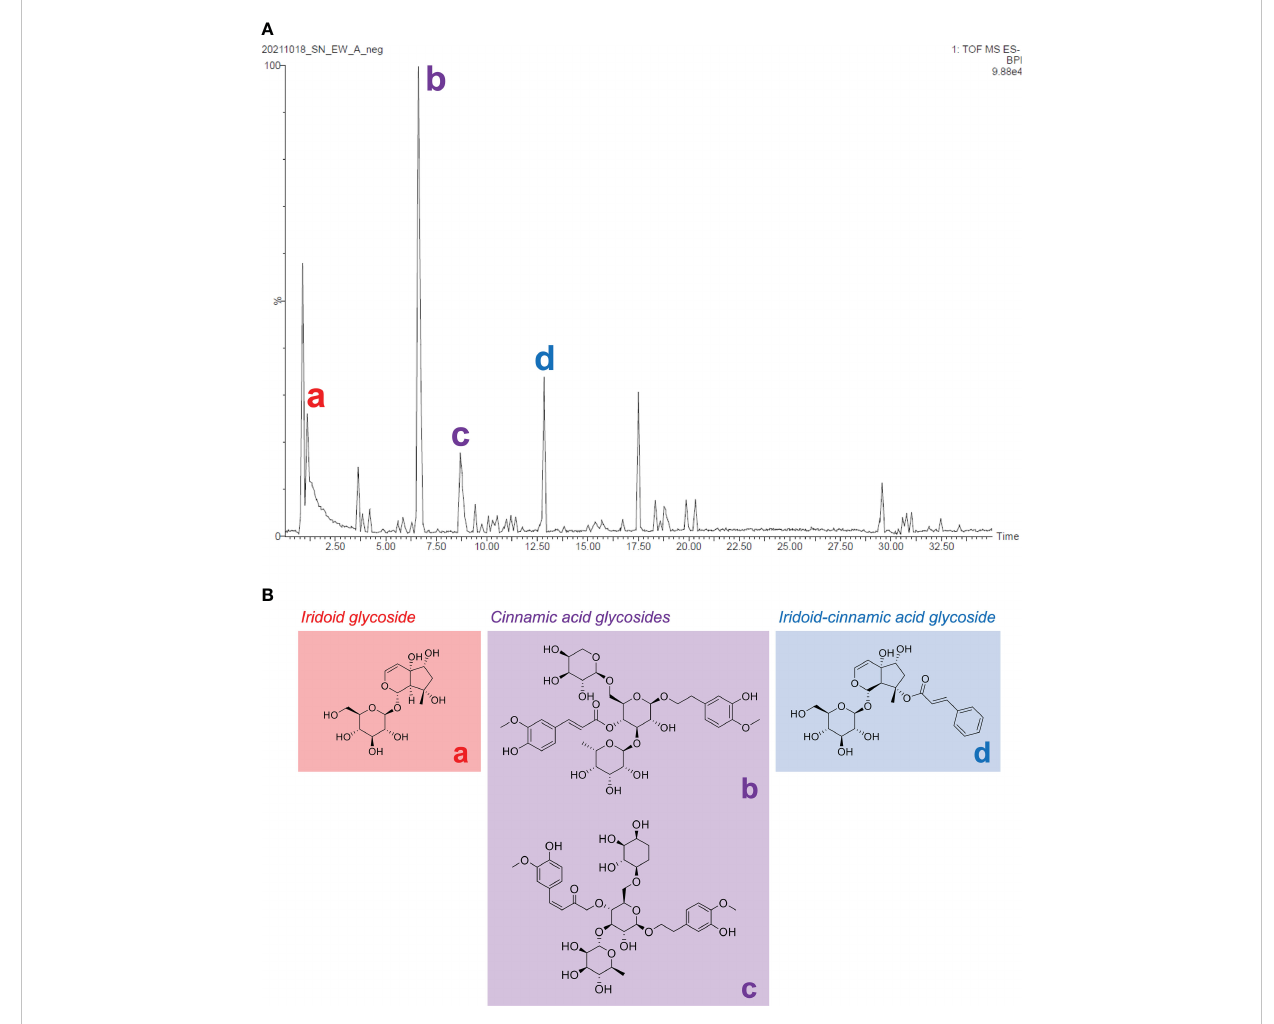
FIGURE 9 The chemical identi fi cation of the major constituents among three major types of compounds from the S. ningpoensis extract. (A) The MS total ion chromatogram in negative mode; (B) the chemical structures of the annotated constituents, harpagide (a), angoroside C (b), isoangoroside C (c), and harpagoside